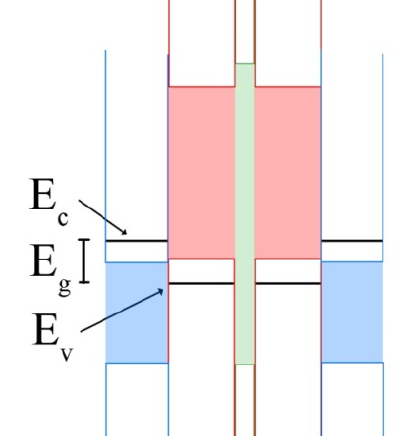
Figure 6. A band diagram of a InAs(blue)/GaSb(red)/AlSb(green) M-SLS. The inclusion of AlSb into the device gives this structure its eponymous band